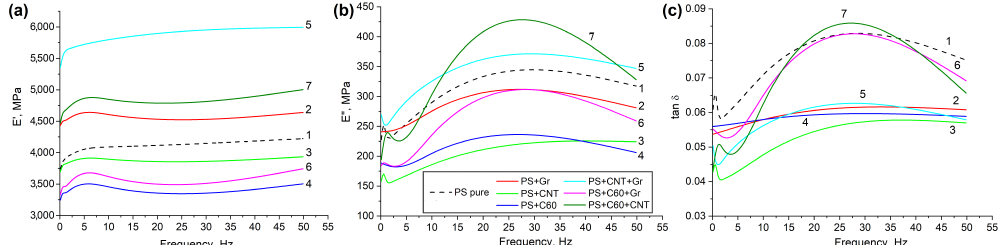
Figure 5. Frequency dependencies of the elastic modulus E (cid:48) ( a ), loss modulus E (cid:48)(cid:48) ( b ) and mechanical loss tangent tan δ ( c ) of pure polystyrene and composites with single-type nanoparticles and binary mixtures: 1—PS pure, 2—PS + Gr, 3—PS + CNT, 4—PS + C 60 , 5—PS + CNT + Gr, 6—PS + C 60 + Gr, 7—PS + C 60 +